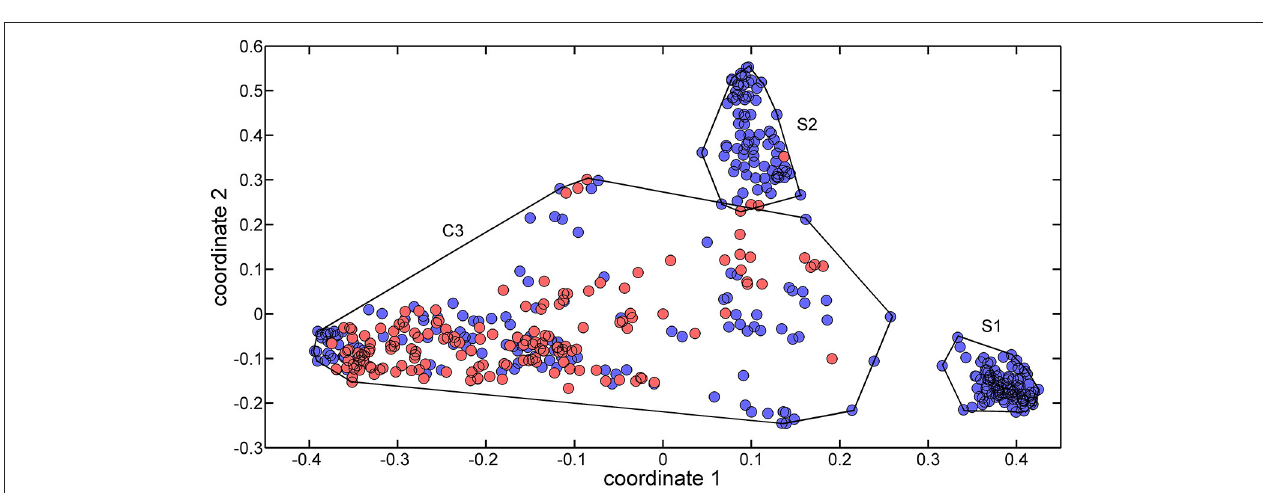
FIGURE 1 | MDS plot of the two first coordinates (explained variance equal to 69.85%) for the training set molecules. Sweet molecules are marked with blue circles, and non-sweet molecules are market with cyan circles.